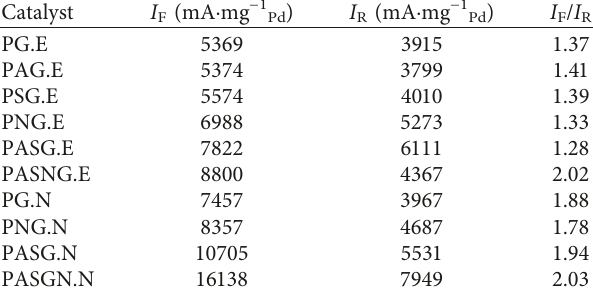
Figure 1: CV (a) and CA curves (b) of (A) PG.E, (B) PAG.E, (C) PSG.E, and (D) PASG.E catalysts in a (NaOH 0.5M +C solution at a scan rate of 50mV · s − 1 . Table 1: CV results of Pd/rGO-based catalysts after 15 scanning cycles in a (NaOH 0.5M+C 2 H 5 OH 1 M) solution at a scan rate of 50mV · s − 1